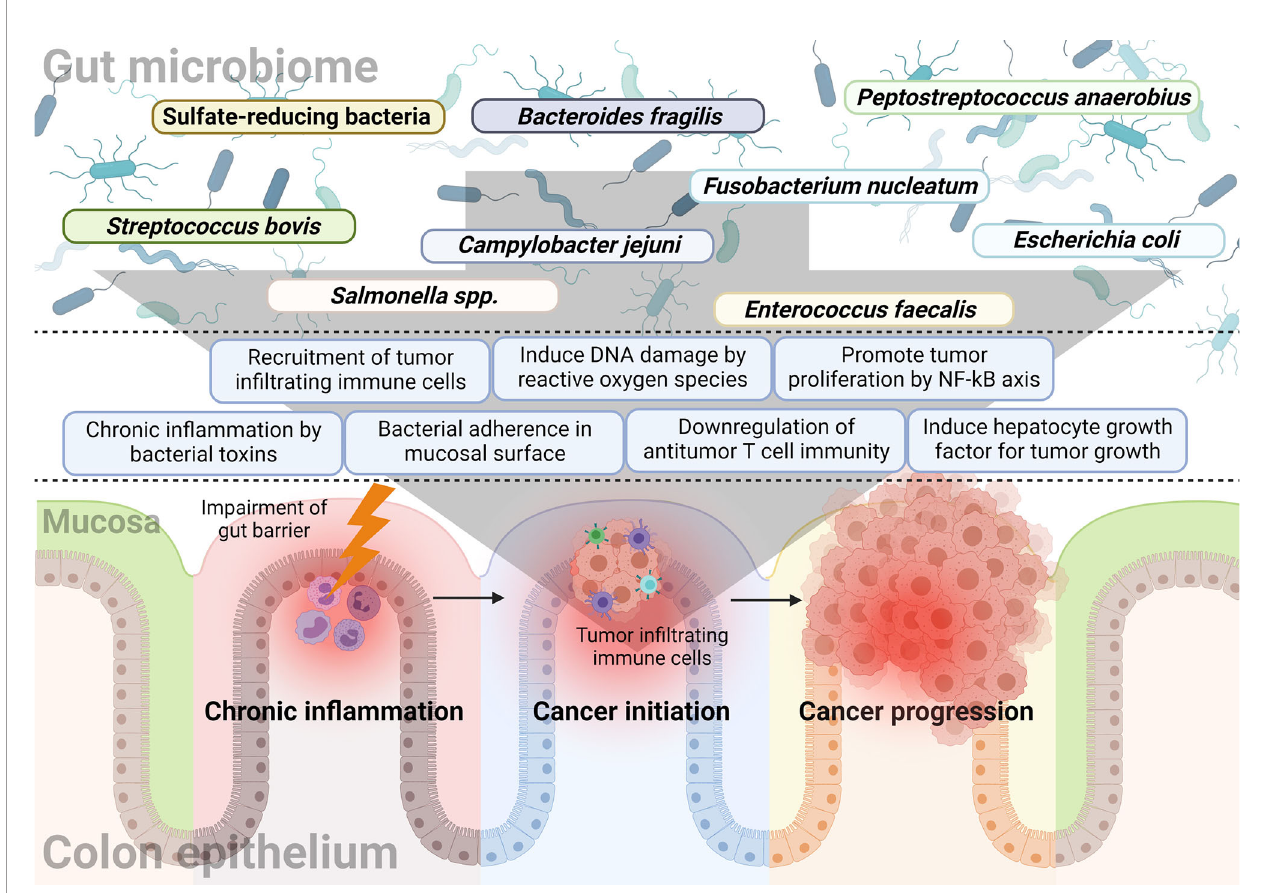
FIGURE 1 | The relationship between the gut microbiome and sequential progression of colorectal carcinoma. Speci fi c gut microorganisms induce chronic in fl ammation in the colorectal epithelium. For example, typhoid toxin or colibactin secreted by Salmonella or E. coli , respectively, leads to pro-in fl ammatory cytokine production and bacterial adherence. Chronic in fl ammation is one of the major causes of CRC and increased ROS with epithelial cell DNA damage also play a major role in cancer initiation by the gut microbiome. Some microorganisms like F. nucleatum and B. fragilis induce a tumor-favorable immune microenvironment by reducing CD3+ T cell density along with the recruitment and proliferation of CD4+CCR6+IL17A+ Th17 cells. Furthermore, bacterial components such as putative cell wall binding repeat 2 surface protein in P. anaerobius activate the NF- k B signaling pathway in CRC tumor cells and promote tumor cell proliferation. Colibactin- producing E. coli encodes enzymes responsible for HGF synthesis and induces senescence and tumor